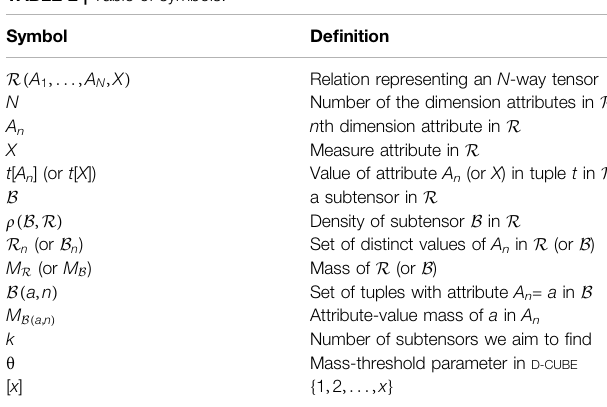
TABLE 2 | Table of